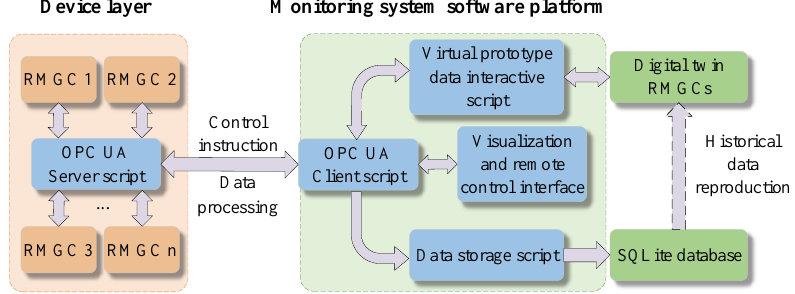
Figure 6. Schematic diagram of data interaction based on OPC